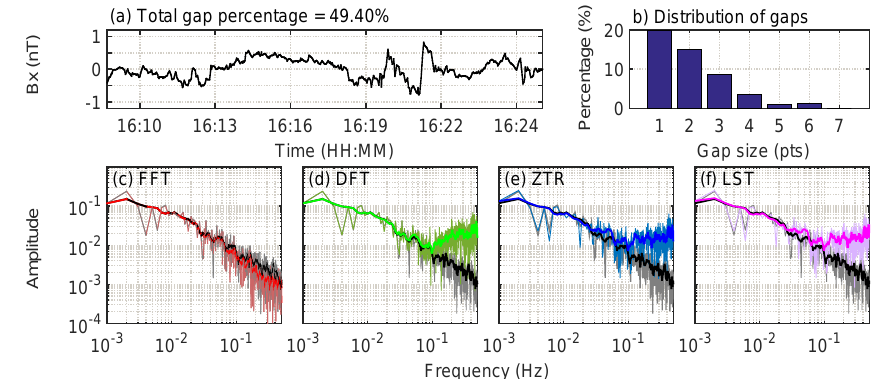
Figure 16. Case study for the MSG test applied to the VEX data set. The format is similar to Fig. 7. Panels (c) , (d) , (e) and (f) also show the original FFT spectrum (black) and the average spectra for each method (thick lines).